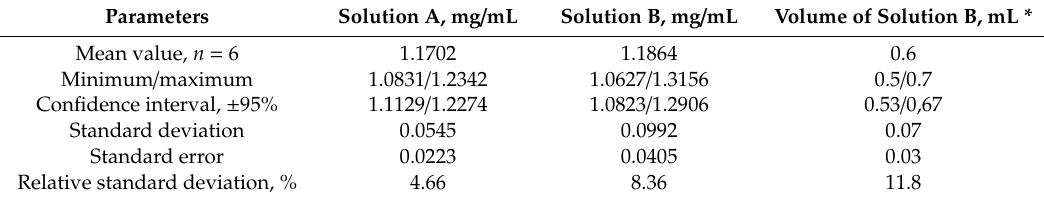
Table 1. Evaluation of the ciprofloxacin-bismuth (Cip-Bi) loaded into the dressing matrix. Cip-Bi hydrogel solution before (solution A) and after (solution B) dressing modification.